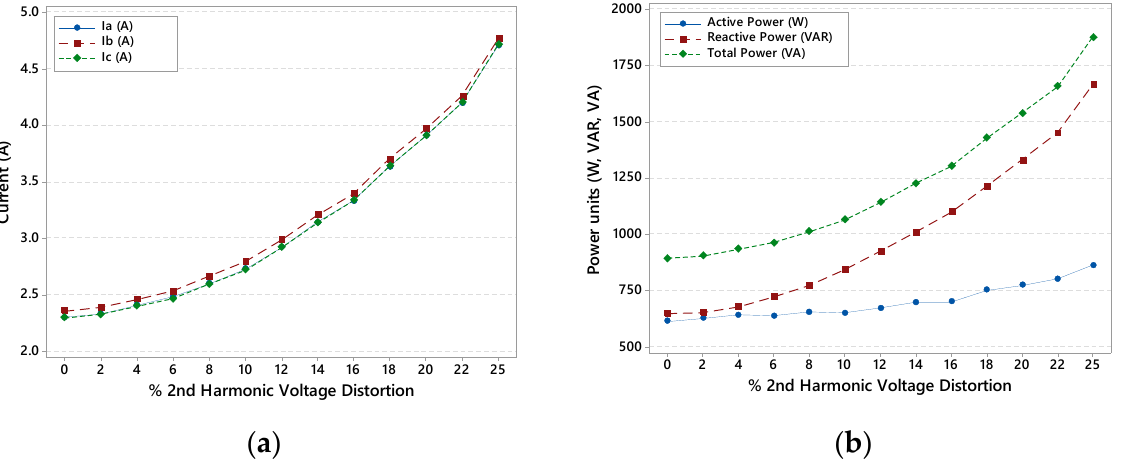
Figure 7. LSPMM in the presence of second voltage harmonic: ( a ) input line currents; ( b ) active, reactive, and total Power.